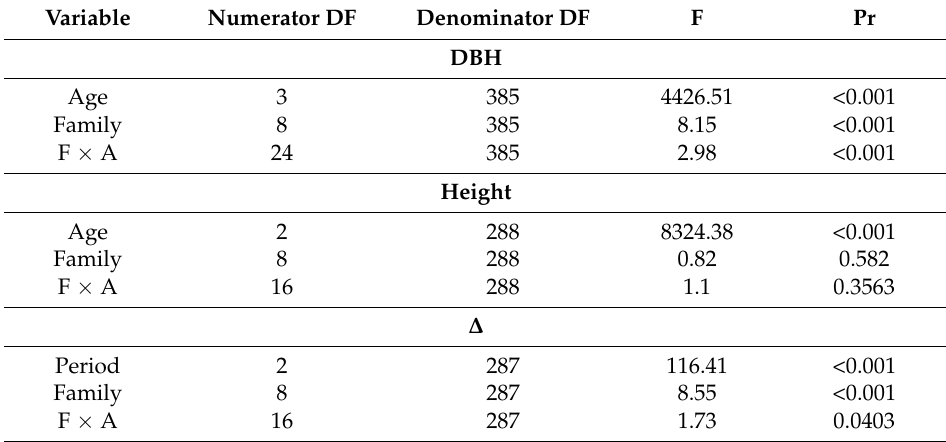
Table 2. F test results for DBH, tree height and carbon isotope discrimination ( ∆ ). Values shown are for age, family and family × age (F × A) interaction effects.